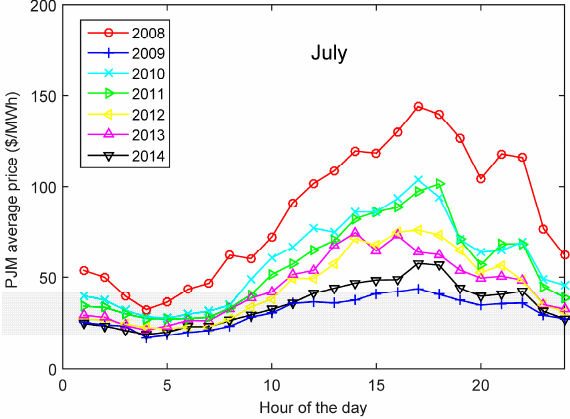
Figure 11. July hourly-based average prices of electricity in RTM, encompassing 7395 nodes.